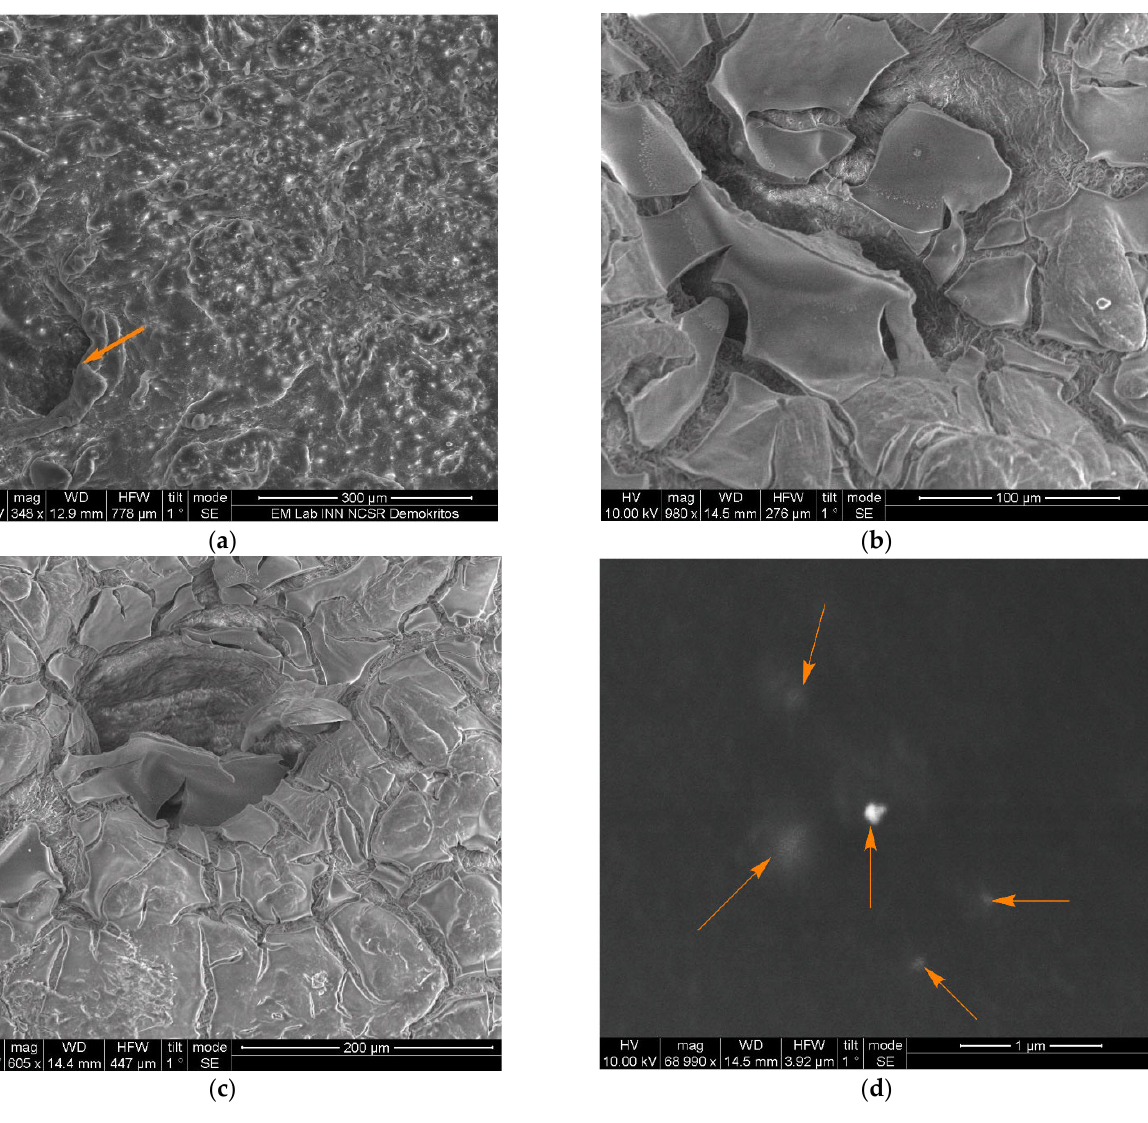
Figure 4. ( a ) SEM micrograph of uncoated leather and a pore (orange arrow); ( b ) SEM micrograph of leather coated in a single stage; ( c ) SEM micrograph coated in multiple stages indicating the penetration of the xerogel into the leather pores; ( d ) Ag nanoparticles incorporated into the xerogels (orange arrows).